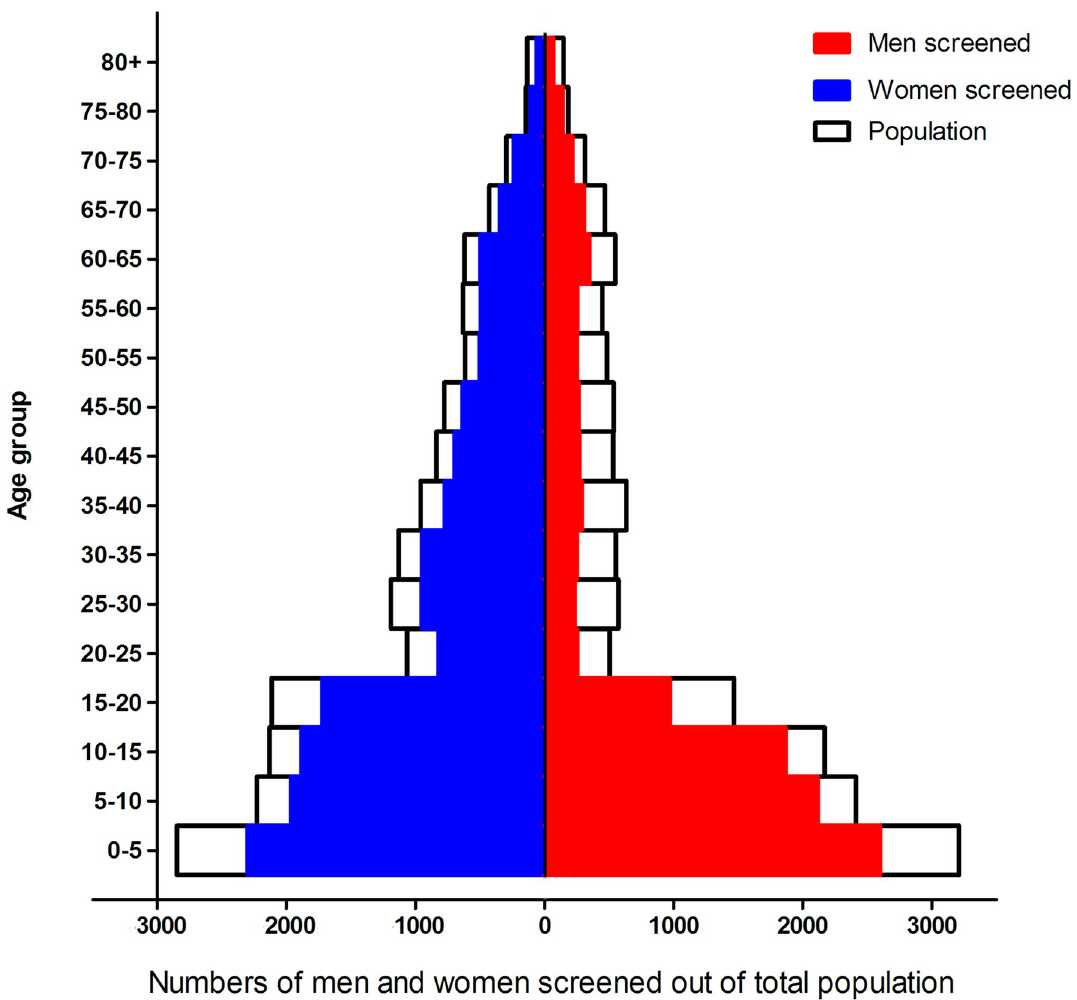
Fig 1. Population pyramid. Population recorded (n = 33,319) and population screened (n =